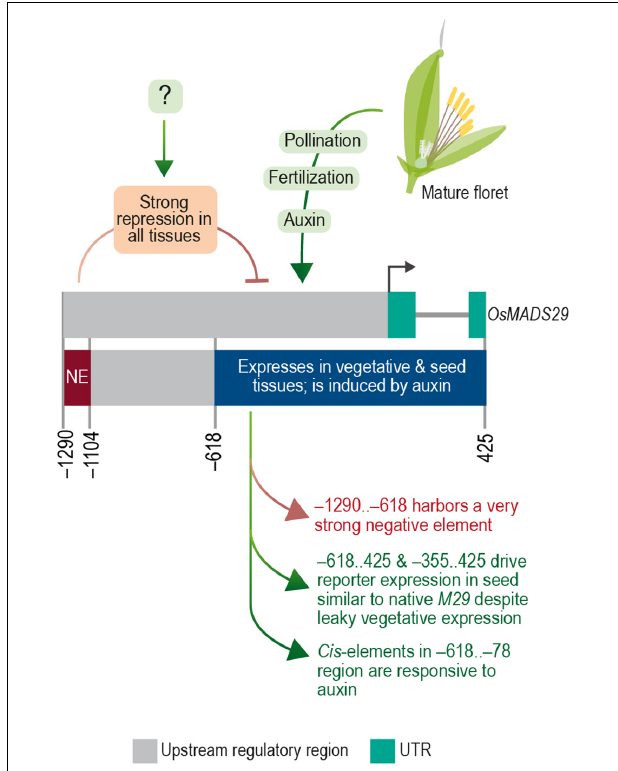
FIGURE 12 | The transcriptional regulatory module of M29. Diagrammatic representation of transcription regulatory domains of OsMADS29 identified in this